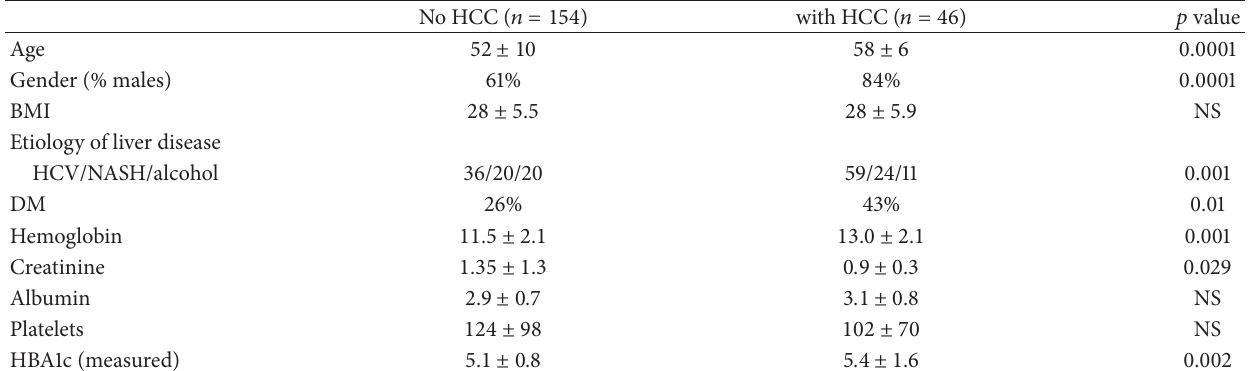
Table 2: Patients with HCC and patients without